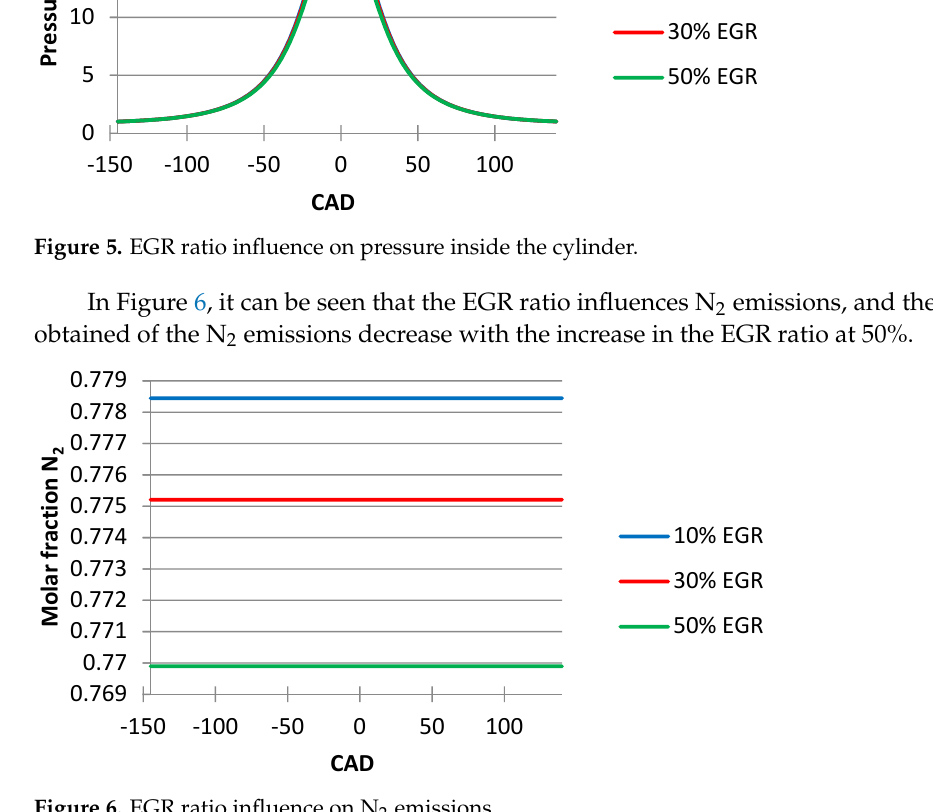
Figure 6. EGR ratio influence on N 2 emissions. In the case of CO emissions with the EGR ratio (Figure 7), the curves for 10% and 30% EGR are similar, but when increased at 50% the shape of the curve is different in the positive domain with an increase in the CO emissions value.